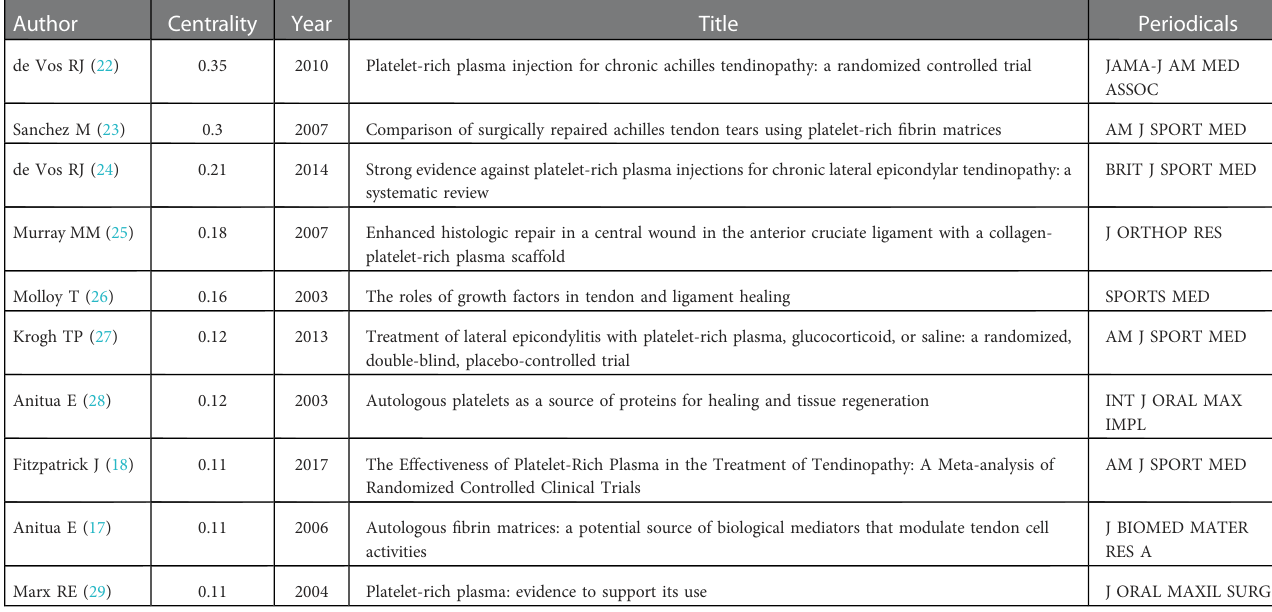
TABLE 5 Top 10 cited literature centrality rankings for using platelet-rich plasma to treat ligament and tendon injuries.